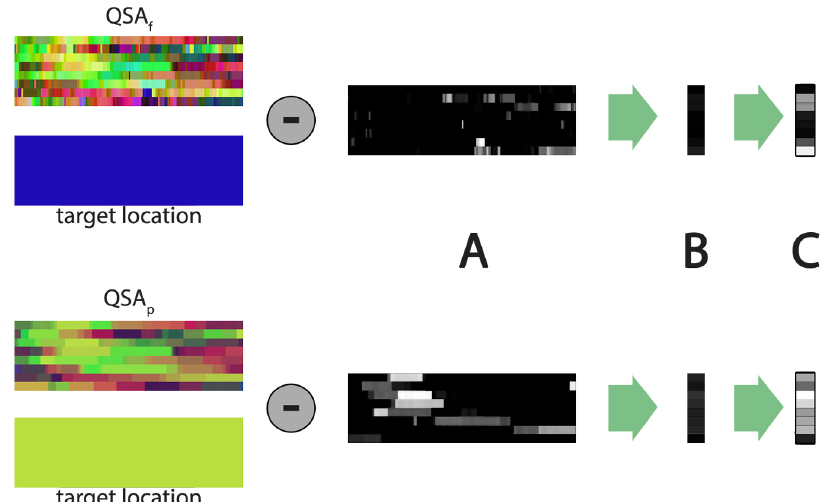
Figure 10. Basic image operations to extract proximity to target locations and performance over the session (portions of QSAs are shown for the sake of clarity). Image subtraction ( A ); temporal resampling ( B ) and normalization ( C